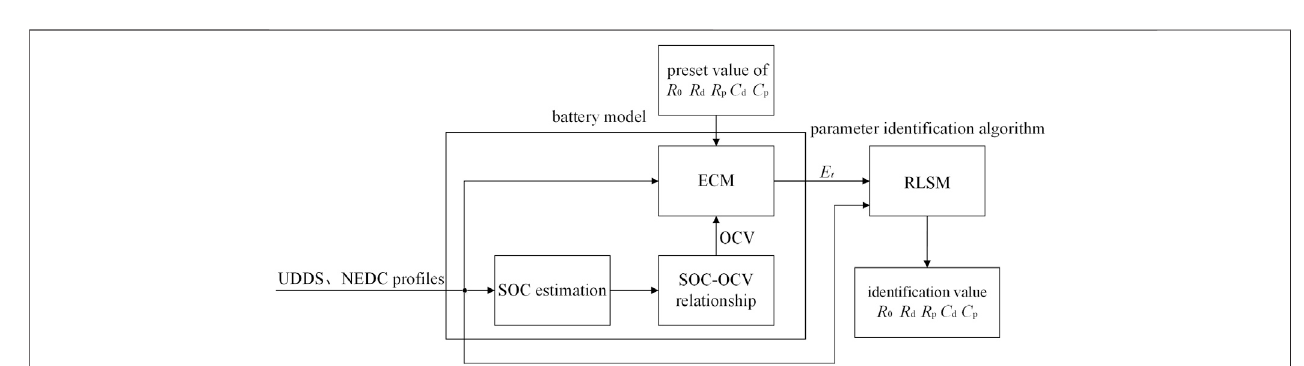
FIGURE 3 | Model of parameter identi fi